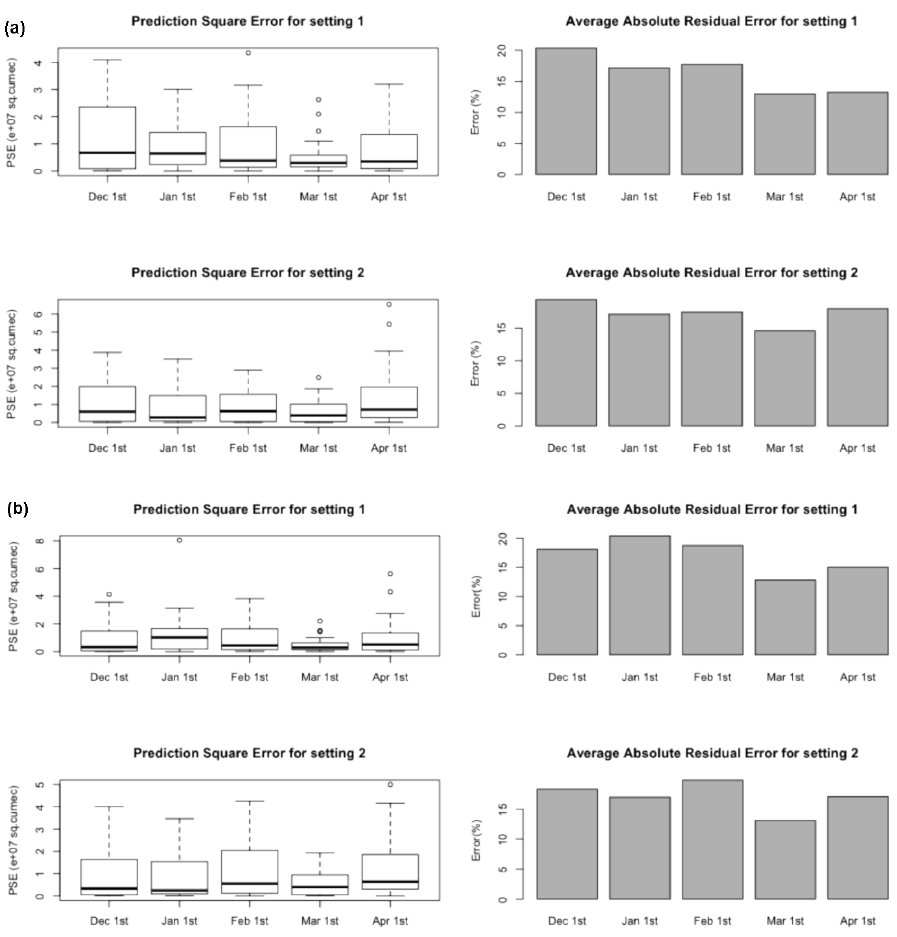
Fig. 6. (a) Cross-validated prediction square errors and average absolute errors corresponding to bestglm (AIC); (b) Cross-validated predic- tion square errors and average absolute errors corresponding to bestglm